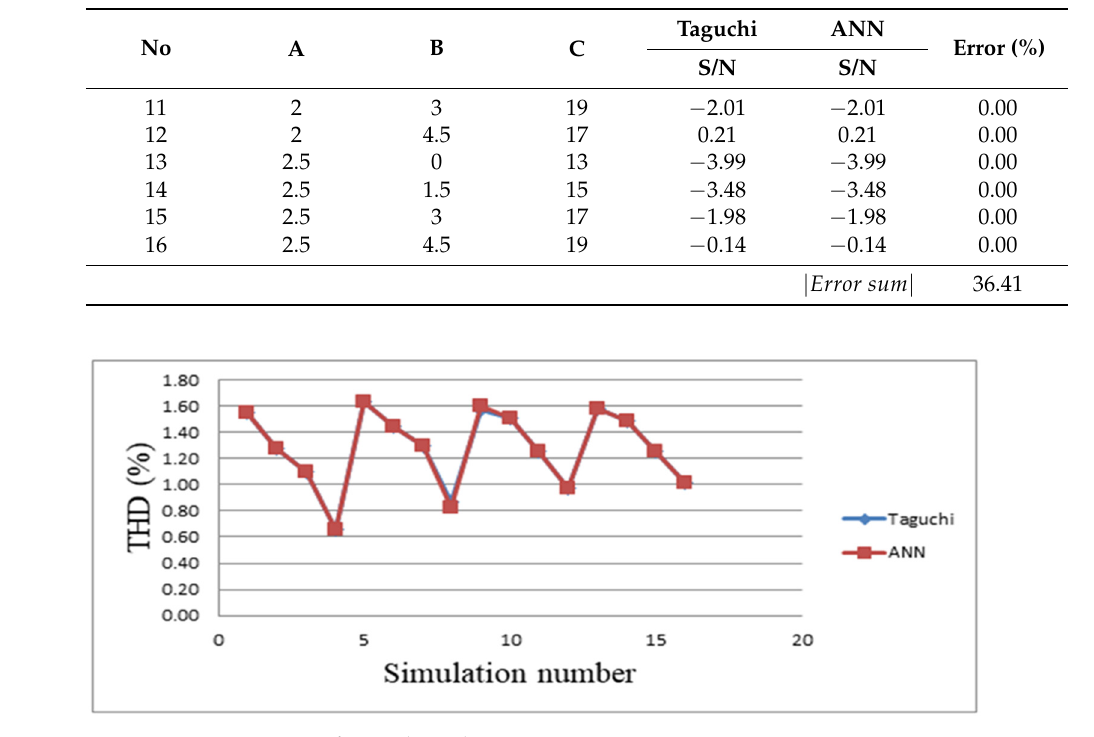
Figure 15. Comparison of Taguchi and ANN.